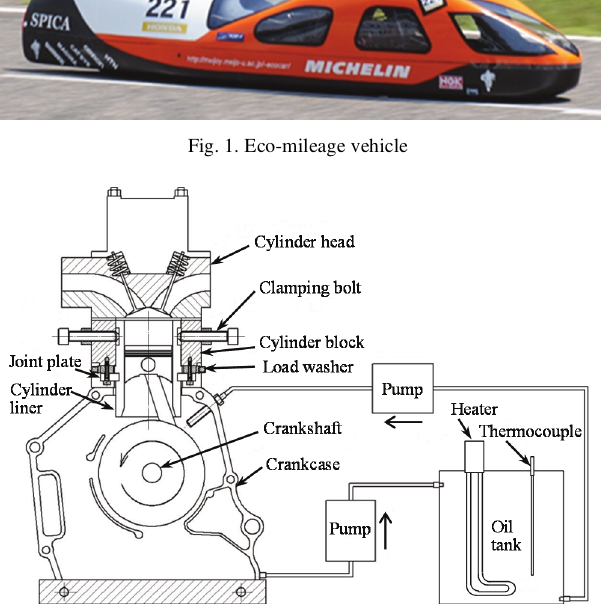
Fig. 2. Measurement apparatus of piston assembly friction